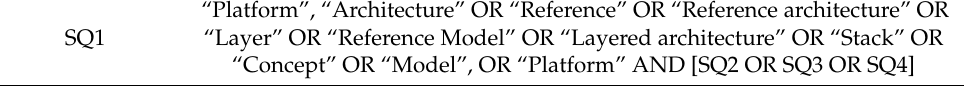
Table 2. Search queries (SQ) used during literature